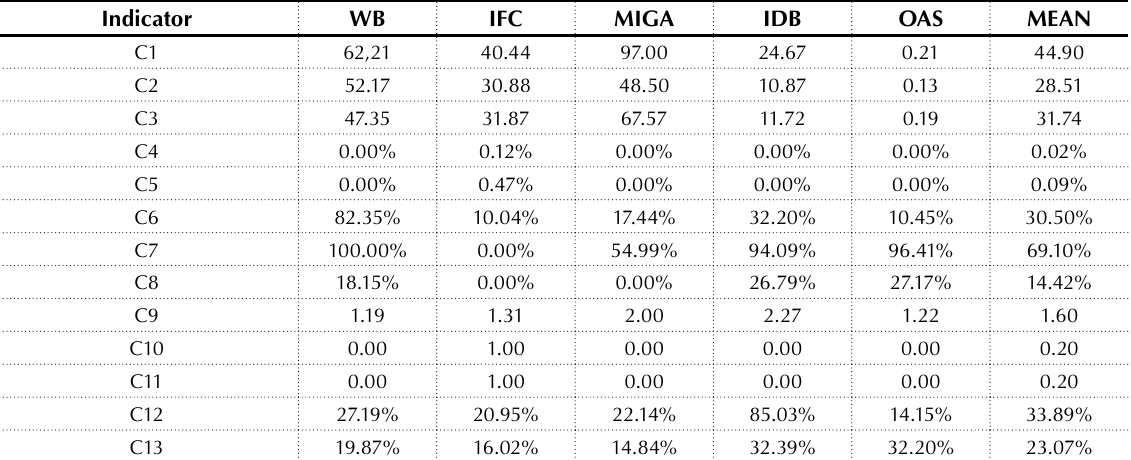
Table 10. Indicators of aspects related to the volume of funding,